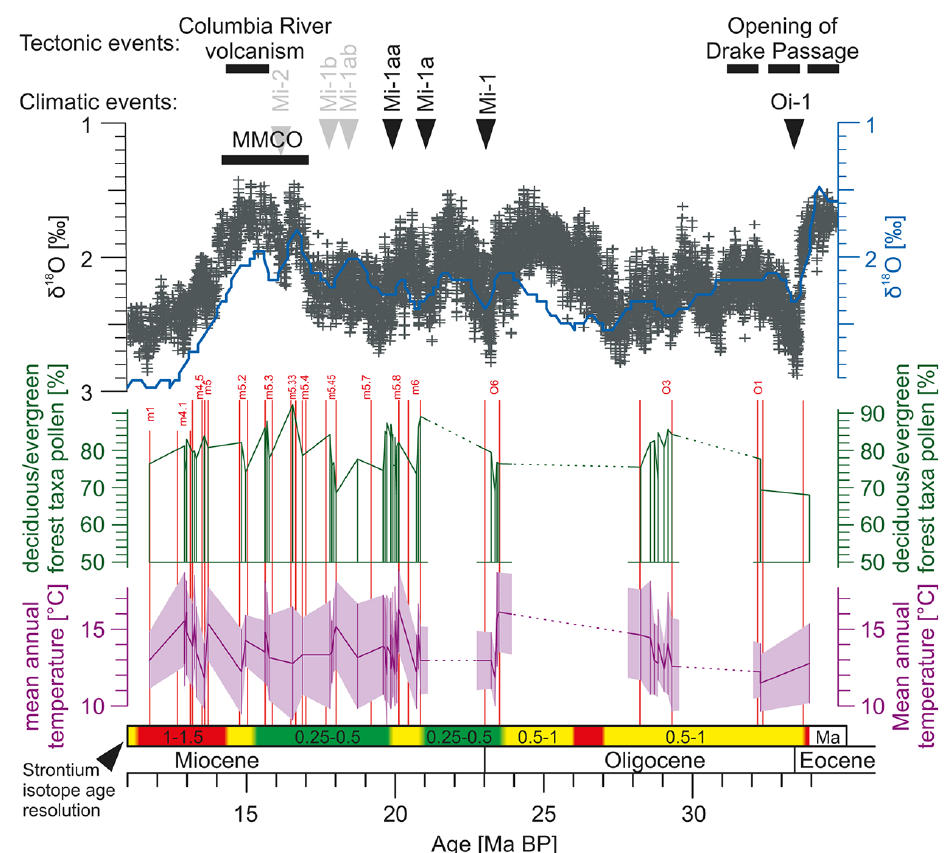
Figure 4. Pollen-based mean annual temperature reconstruction and deciduous–evergreen forest taxa pollen percentages for Site M0027 vs. age compared to a stacked and smoothed oxygen-isotope record from the Pacific (after Cramer et al., 2009), global oxygen-isotopes after Zachos et al. (2001a, 2008), and global events (position of Mi events after Miller et al., 1991; Pekar and DeConto, 2006). Age model for Site M0027 after Browning et al. (2013) and Miller et al. (2013). Strontium isotope age resolution after Browning et al. (2013); green: 0.25 to 0.5Ma, yellow: 0.5 to 1.0Ma, red: >